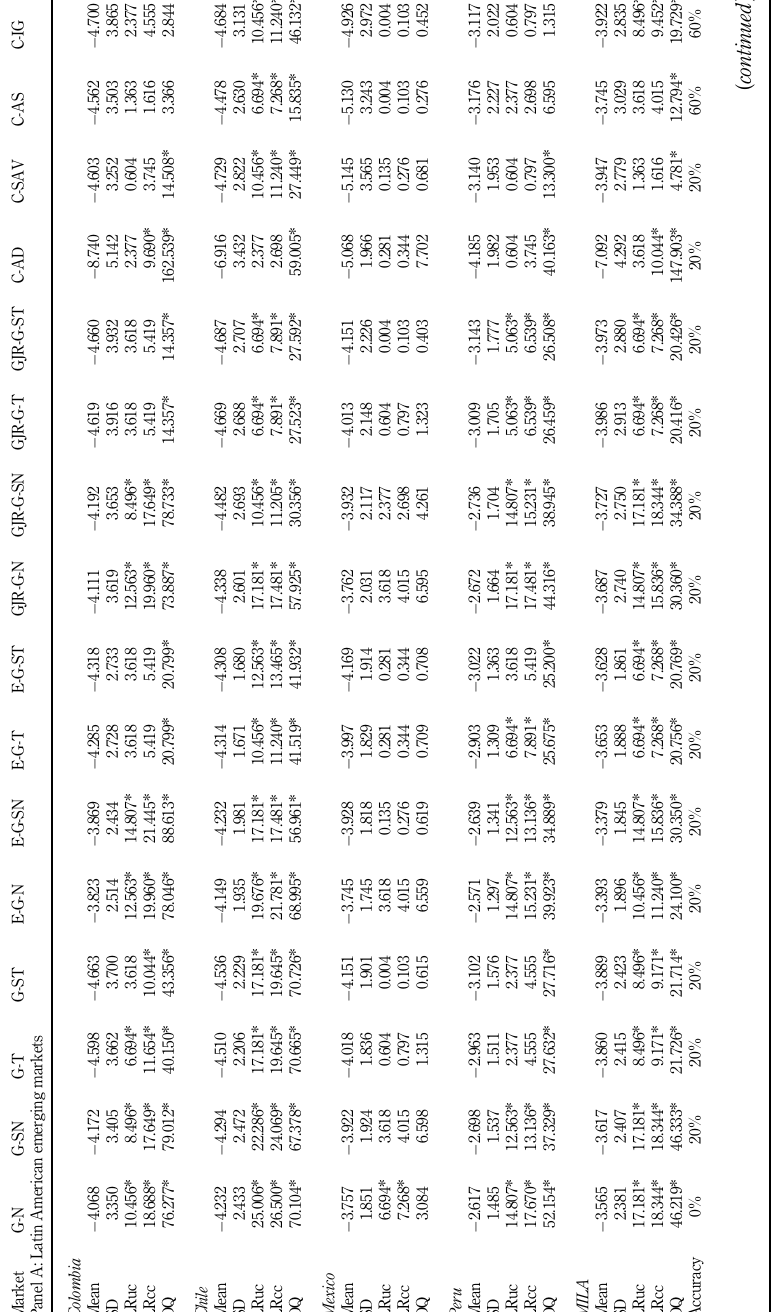
Table 7. Backtesting results